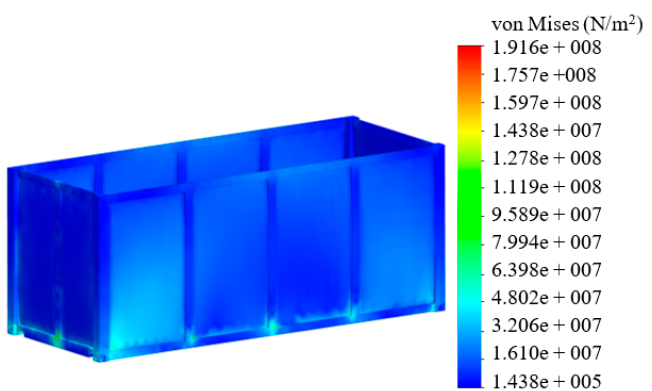
Figure 10. Stress strain state of a container.